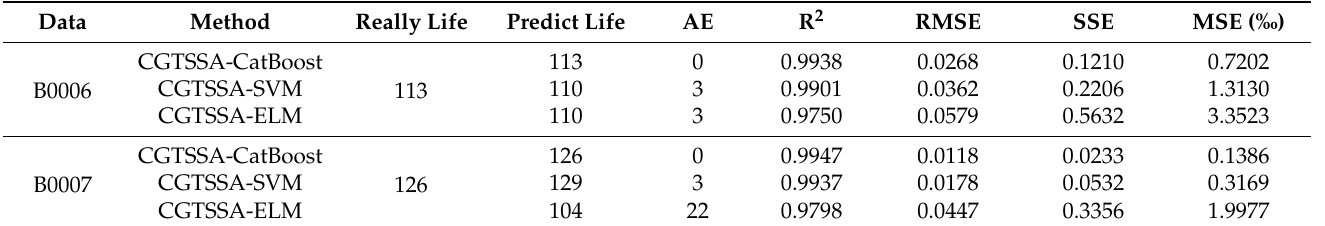
Table 4. Detailed prediction results of various models.